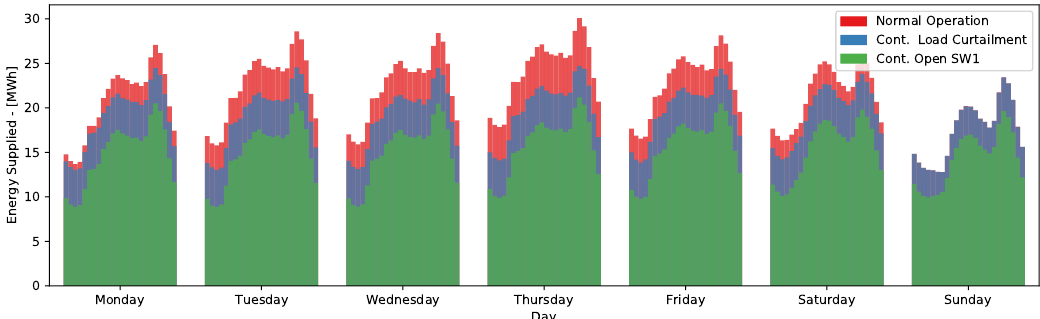
Figure 8. Energy Supplied by hour for the three assumed scenarios: normal operation, conventional method (Open SW1), and proposed method (Load Curtailment).